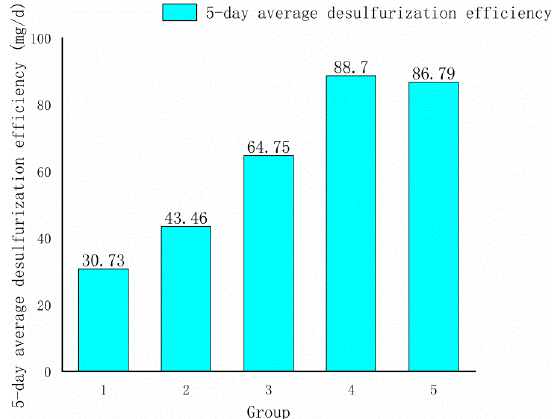
Figure 2. Histogram of the steepest climbing test results.